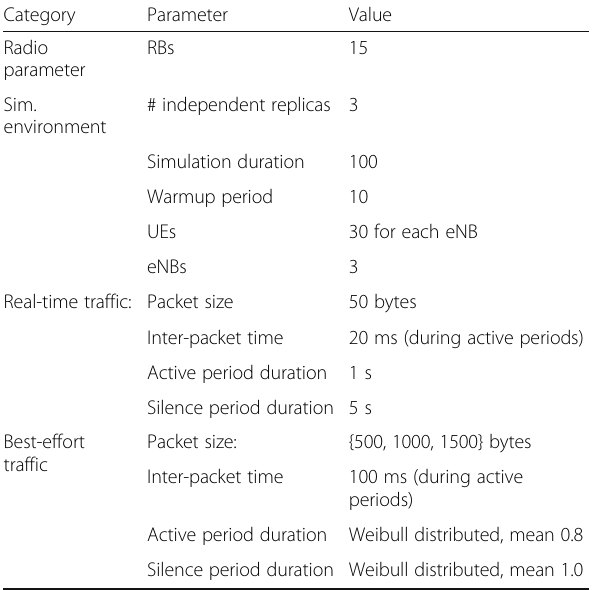
Table 1 Main simulation parameters